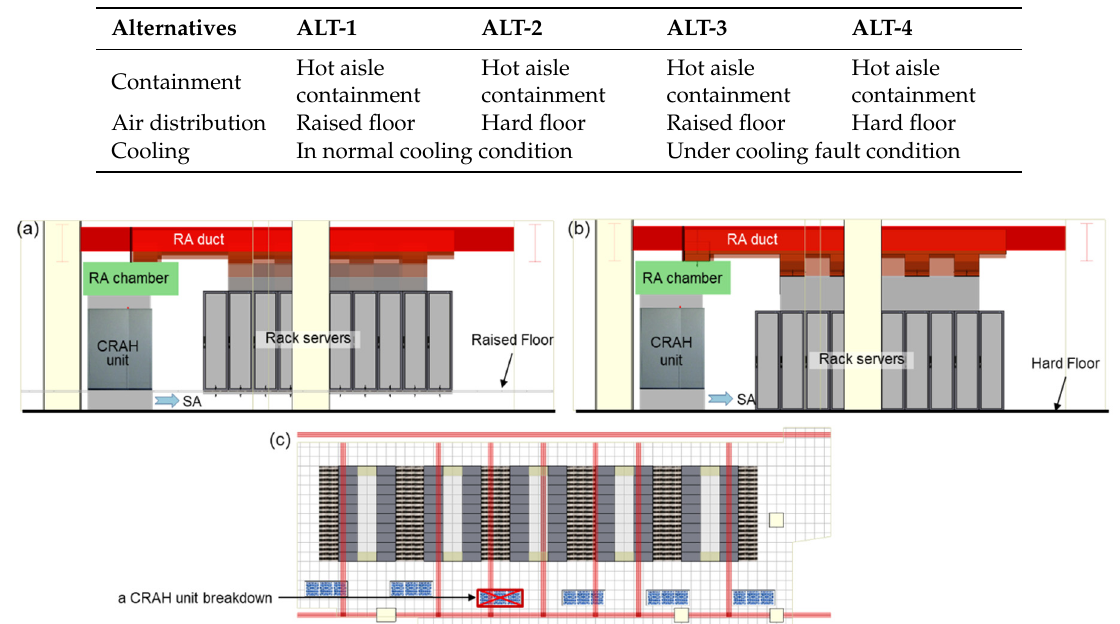
Table 3. CFD simulations adopted in four alternatives.